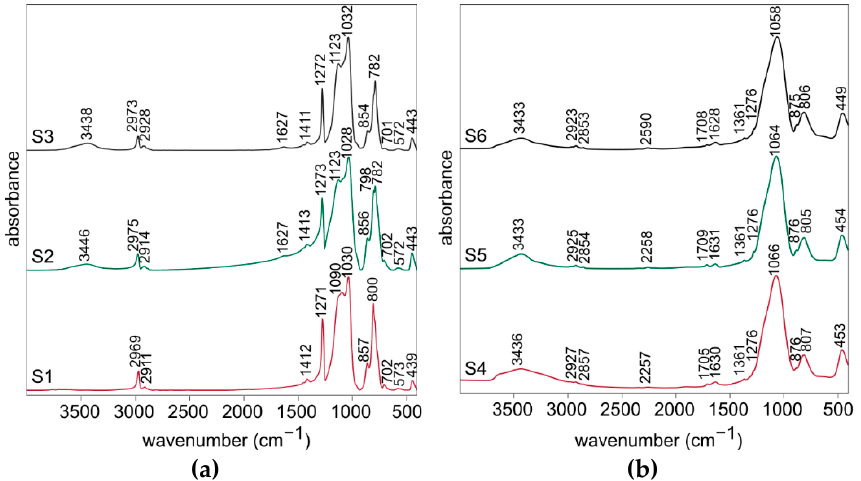
Figure 2. FT-IR spectra for ( a ) the xerogels (S1–S3 samples) and ( b ) the silicon oxycarbide materials (S4–S6 samples). (S4–S6